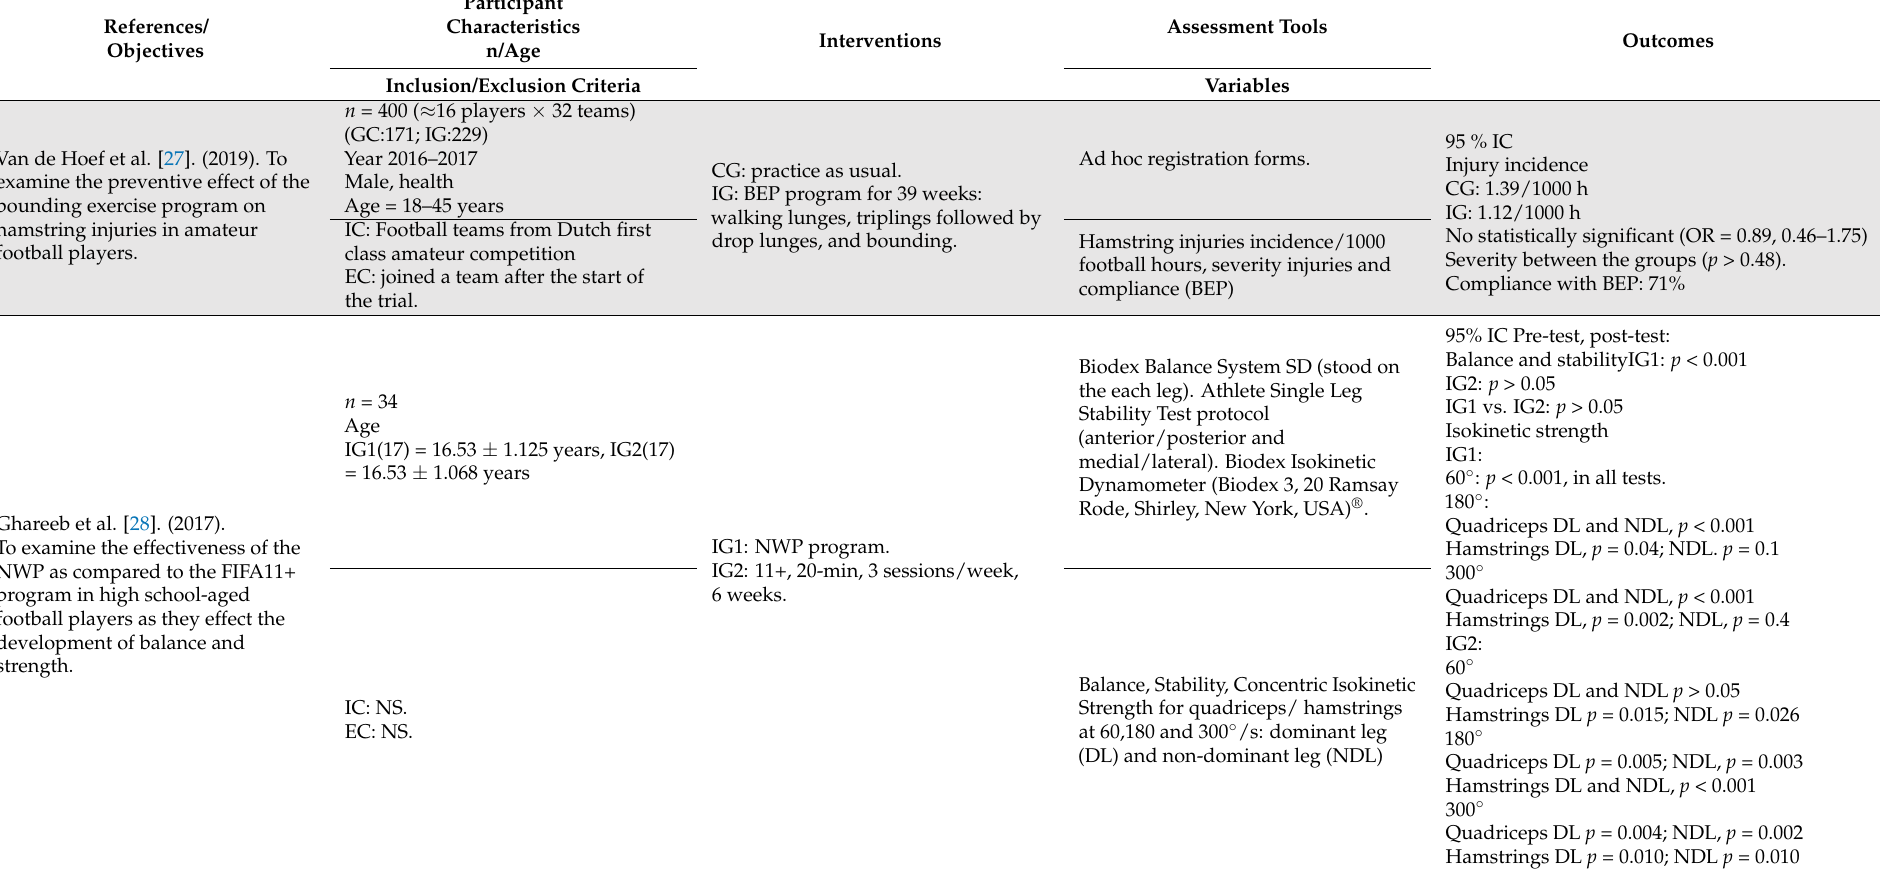
Table 1. Characteristics of the selected